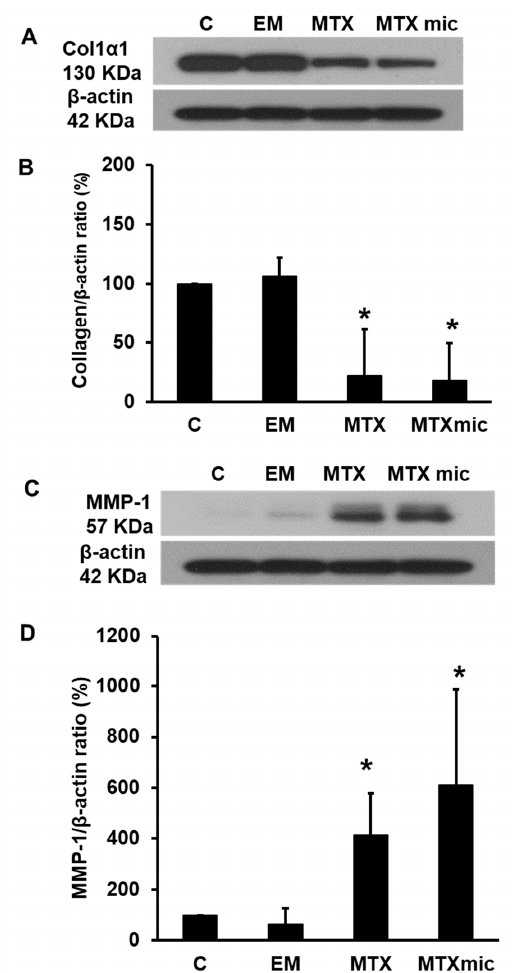
Figure 4. The effect of MTX released from microspheres on type I procollagen and MMP-1 expression in primary human dermal fibroblasts ( A , C ). Representative Western blot of cell lysates of fibroblasts treated with 50 ng/mL of freshly made MTX solution or MTX released from microspheres. Quantitative analysis of the relative procollagen ( B ) and MMP-1 ( D ) expression, normalized to β -actin as loading control, revealed that cells treated with MTX (freshly made or released from microspheres) express significantly less type I procollagen and more MMP-1 than untreated or treated with supernatant of empty microspheres. Data represent the mean ± SD for n = 3. * Statistical significance, p = 0.004.